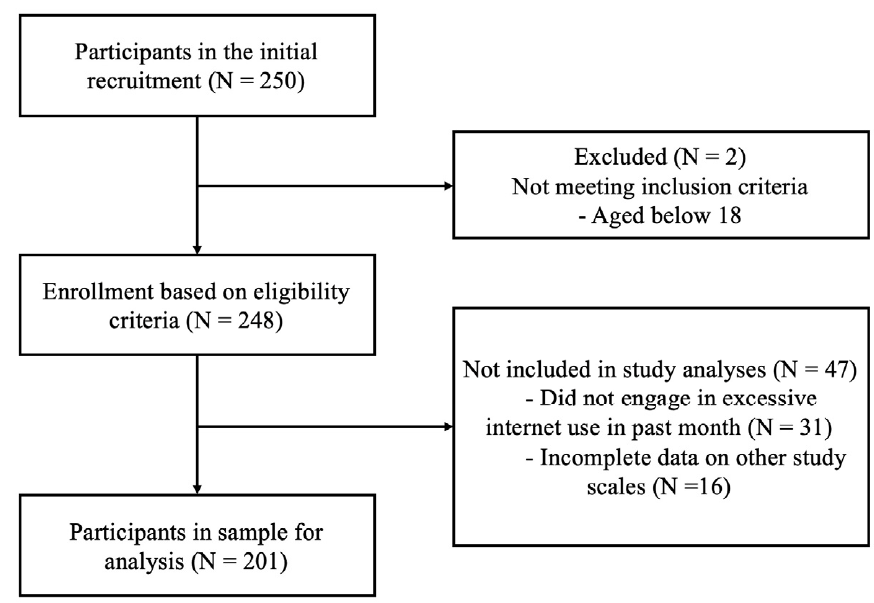
Figure 1. The flow chart of the study procedures.